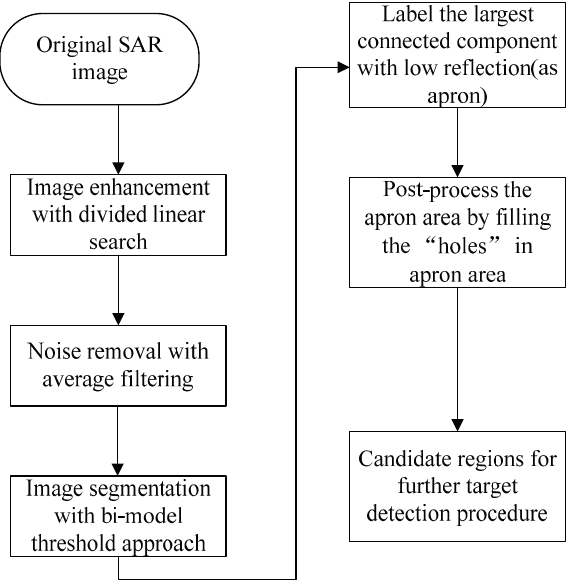
Figure 3. Detection procedure of apron and candidate regions